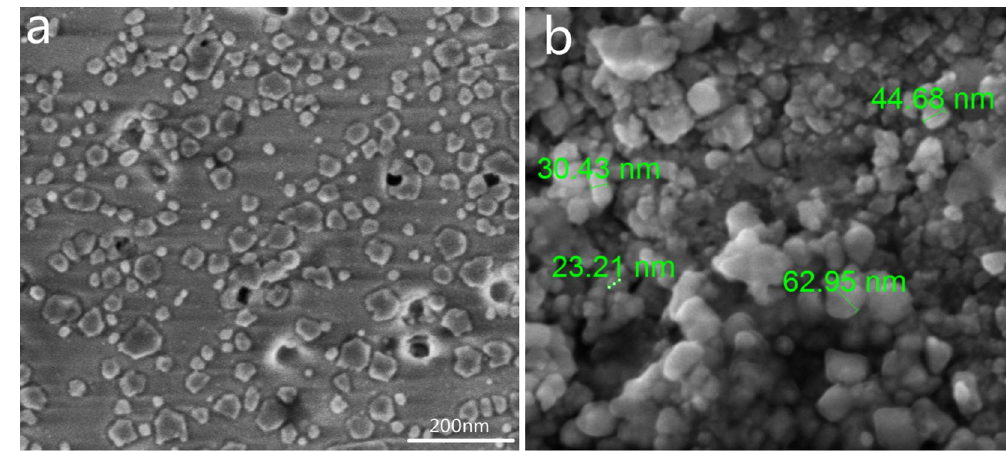
Figure 2. The SEM images of the SABYb-2-640 glass-ceramics after heat-treated at 640 °C for 2